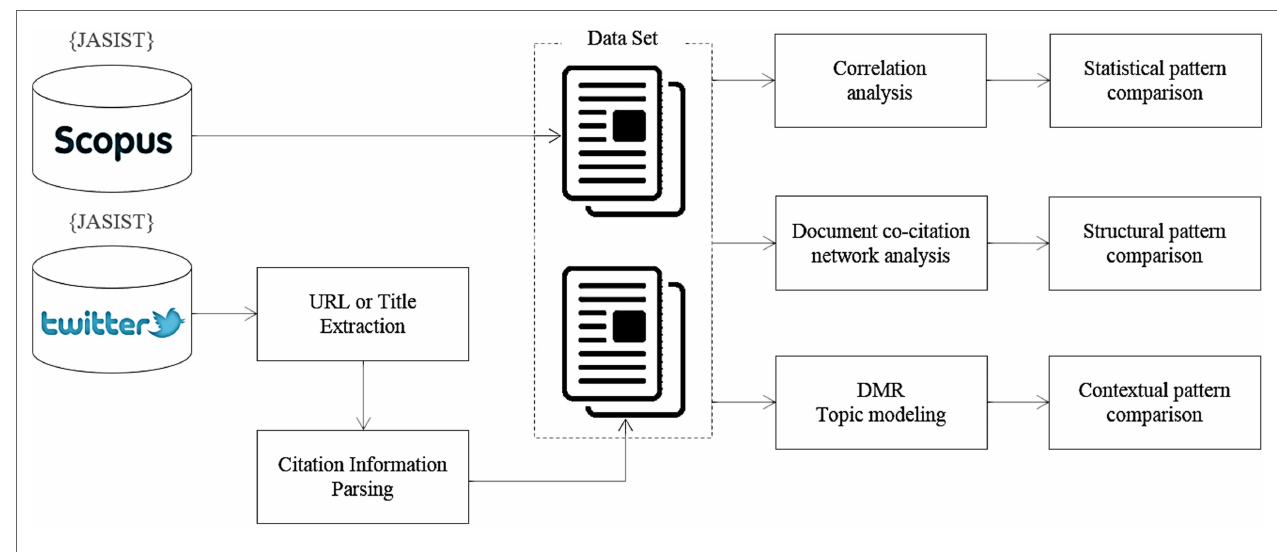
FigUre 2 | Methodology